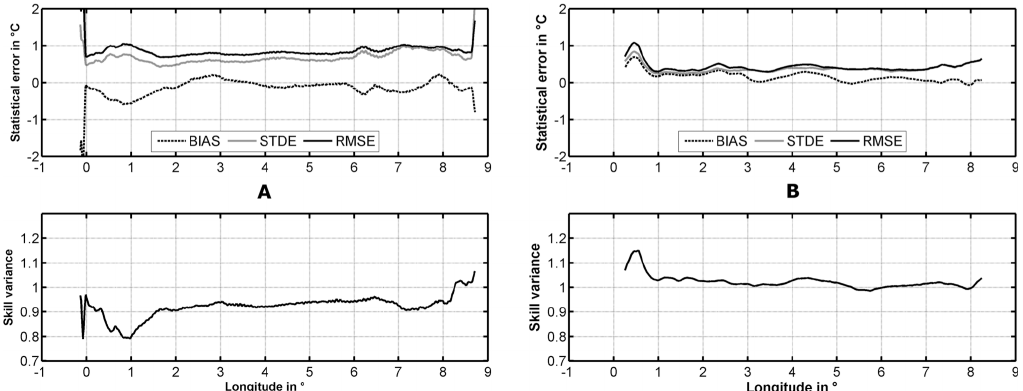
Figure 6. Standard deviation of error (stde), bias and root mean square error (RMSE) (up) and skill variance (skvar) (down) of BSHcmod 2009–2011 (a) and AMM7 (b) 2011–2012 for water temperatures on the TorDania